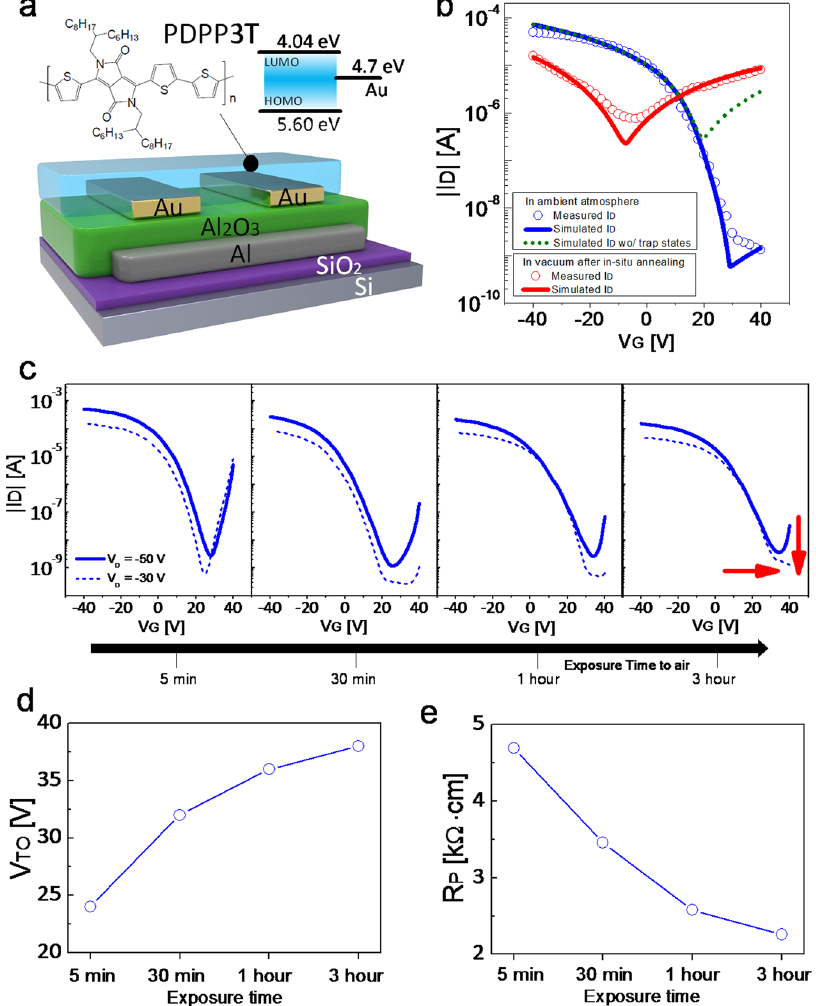
Figure 1. PDPP3T ambipolar transistor architecture and characteristics as a function of air exposure time. ( a ) PDPP3T molecular structure, its schematic and the energy band level. ( b ) Measured (symbols) transfer characteristics of PDPP3T ambipolar transistor at V D = − 30 V in ambient atmosphere (blue) and in vacuum after annealing (red). Lines indicate results from 2D numerical simulations. Blue (green) line: simulation of air exposed PDPP3T OTFTs with (without) trap states. Red line: simulation of vacuum annealed PDPP3T OTFTs. ( c ) Measured transfer characteristics at V D = − 50 V and V D = − 30 V as a function of the air exposure time. ( d ) Turn-on voltage (V TO ) of PDPP3T transistor as a function of the air exposure time. ( e ) Extracted contact resistance value of PDPP3T transistor as a function of the air exposure